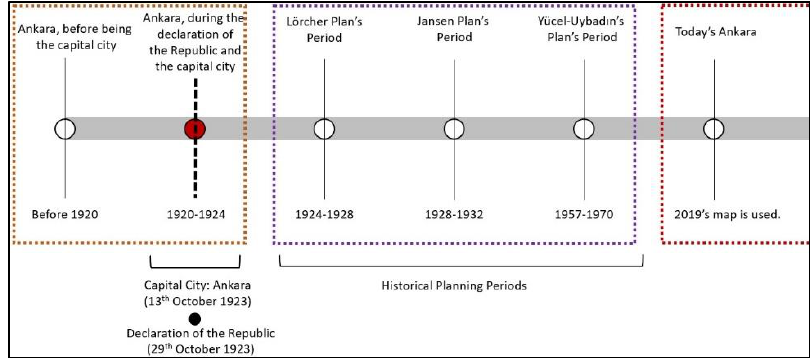
Figure 3 The historical periods examined by the study with Space Syntax